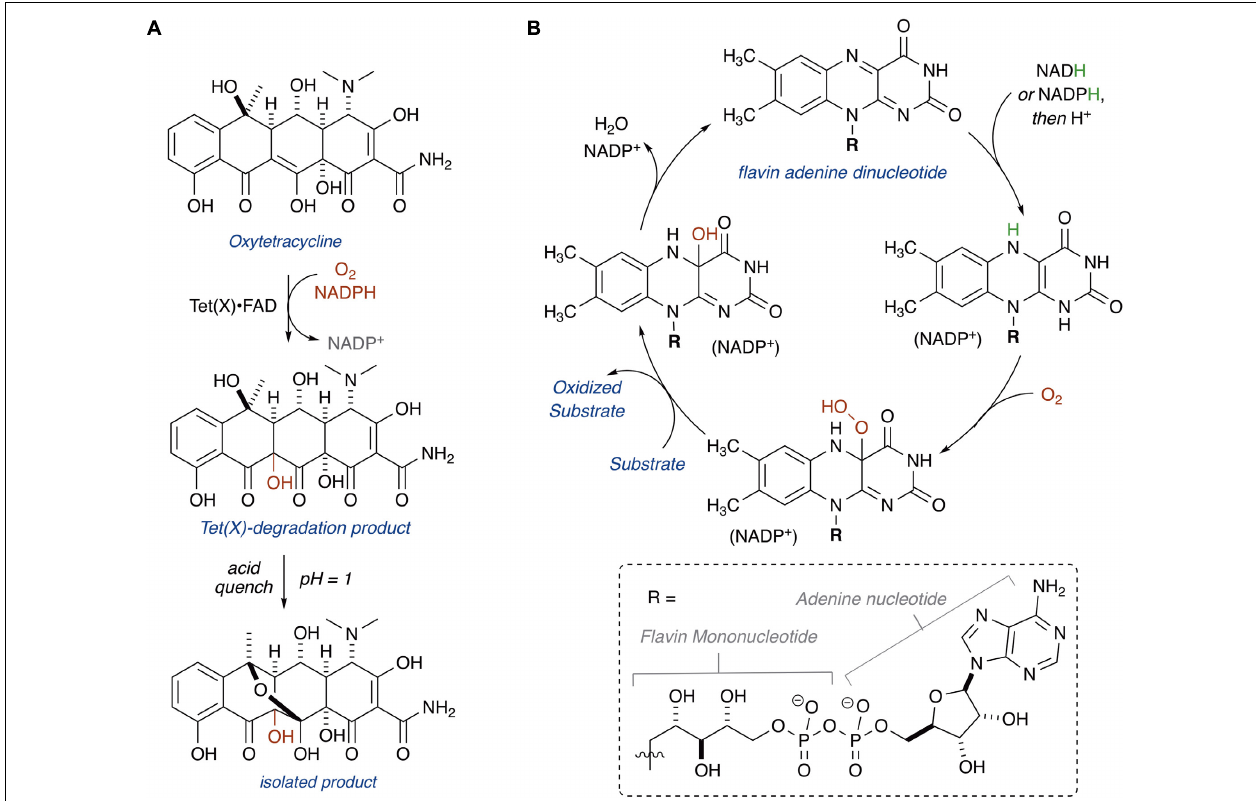
FIGURE 3 | (A) Hydroxylation of oxytetracycline by TetX. (B) Mechanism of class A FMOs.